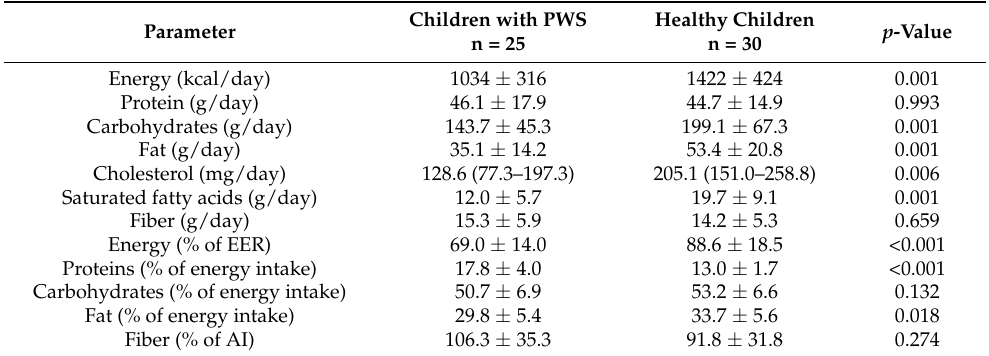
Table 2. Daily energy and nutrient intake of the examined children with PWS and the control group.